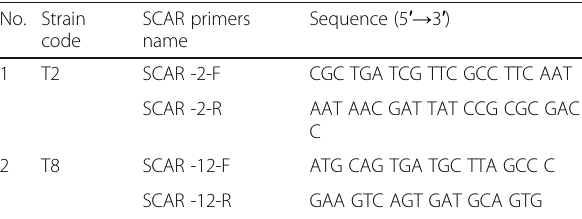
Table 2 List of SCAR primers name and sequence with related Trichoderma